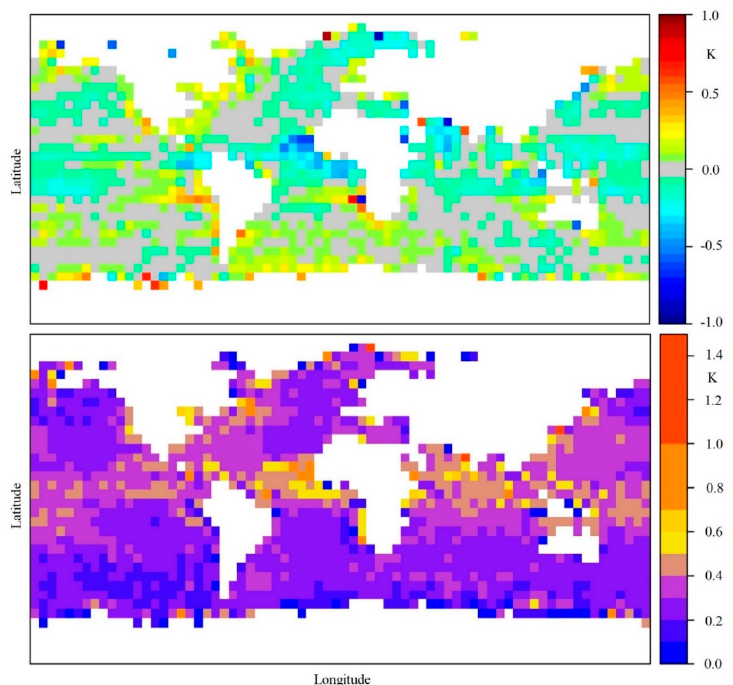
Figure 11. VIIRS SST skin values relative to subsurface temperatures measured from buoys separated into six latitude bands, as shown at right. The box represents the inter-quartile range, the black bar is the monthly median, and the whiskers show the outliers. The red horizontal line at − 0.17 K is the expected cool skin offset. Data are for best quality retrievals.